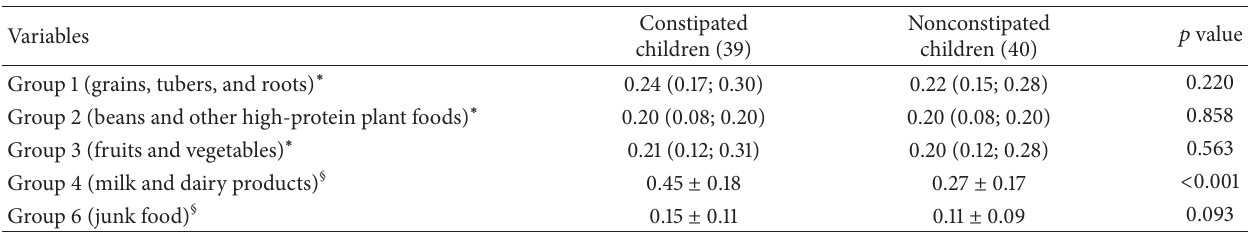
Table 3: Median and interquartile ranges of the food intake frequency scores of constipated and nonconstipated children. Variables Group 1 (grains, tubers, and roots)